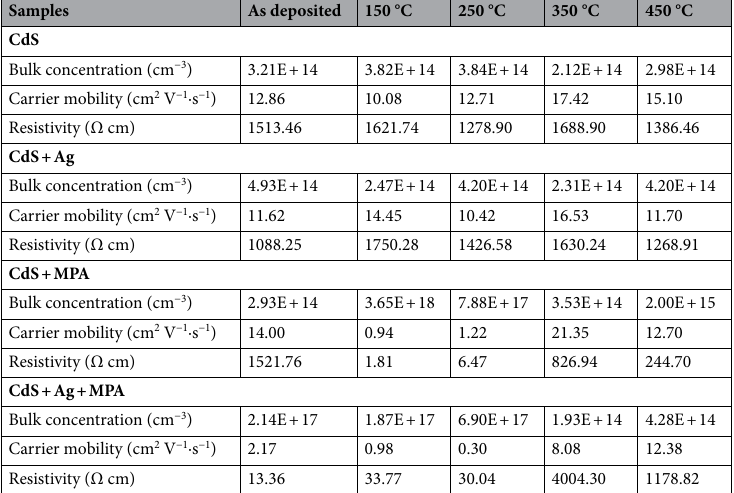
Table 5. The electrical properties of CdS thin